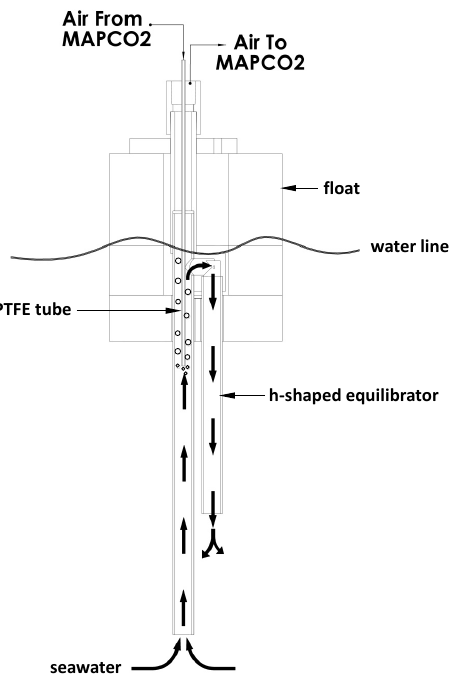
Figure 2. Schematic diagram of the floating air–water equilibrator assembly in the MAPCO 2 system during the seawater equilibration cycle. Air is pumped from the MAPCO 2 through a PTFE tube and bubbled into the equilibrator. As the bubbles rise through the water, the air comes into equilibrium with the dissolved gases in the sur- face seawater. The rising air bubbles in the equilibrator also create circulation by pushing water up and over the horizontal leg of the h- shaped equilibrator and out the short leg of the equilibrator. Image is not to